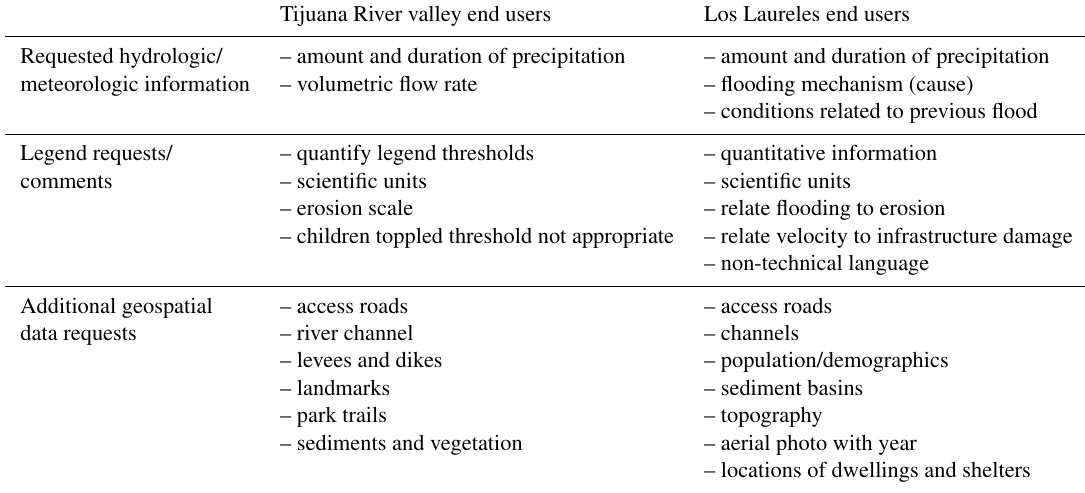
Table 1. Summary of the end users’ requested map revisions. These specific requests were identified through transcript content